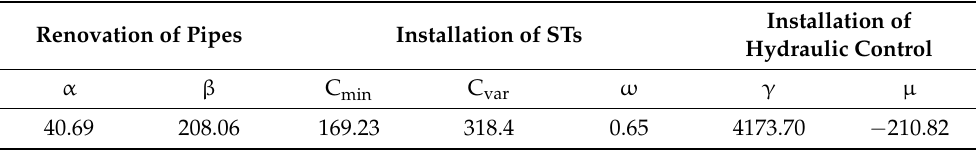
Table 2. Coefficients of the cost terms of Pipes, STs and Hydraulic Control.